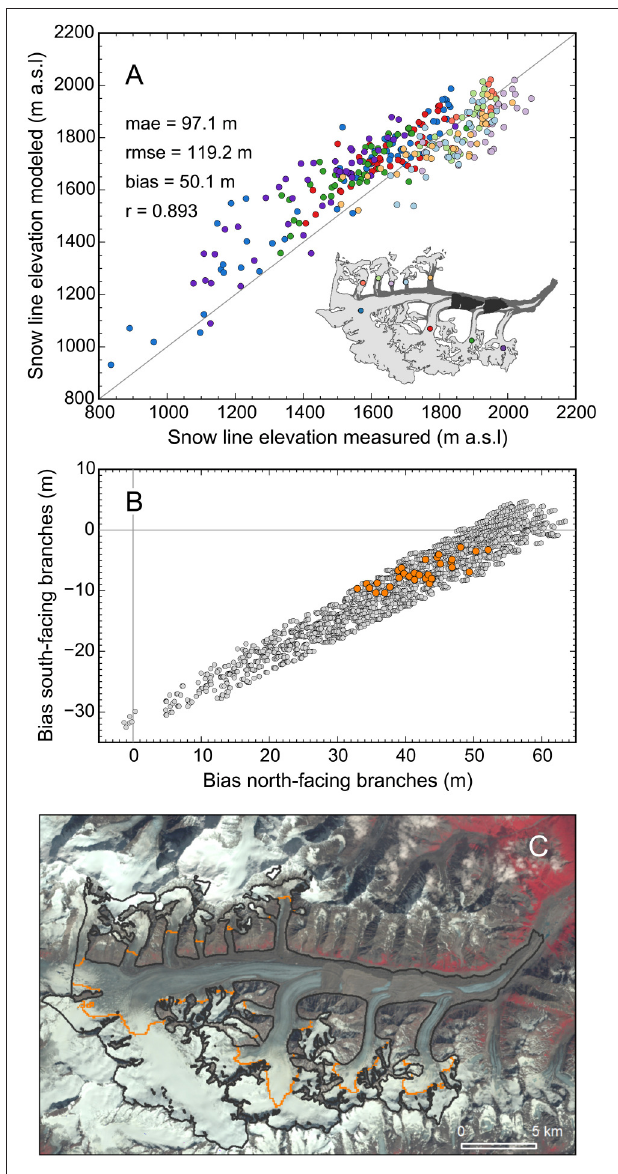
FIGURE 8 | (A) Modeled vs. measured snow line elevations for the same parameter combination shown in Figure 6A . Among the 40 best parameter combinations, the solution shown has a relatively poor match with the measured snow lines. The color code in the inset map distinguishes individual branches. (B) Biases across the south-facing branches vs. biases across the north-facing branches for the 4,576 parameter combinations matching the three geodetic mass balances (gray points) and the 40 final parameter combinations (orange points). Ten final parameter combinations have identical biases, as the combinations differ only in the moraine debris melt reduction factor ( d ), which does not affect the snow line elevations. (C) Modeled snow lines (orange lines) vs. observation (Landsat Thematic Mapper (TM) composite) for August 8, 2005, illustrating that modeled snow lines are too high in the north facing branches and too low in the south facing